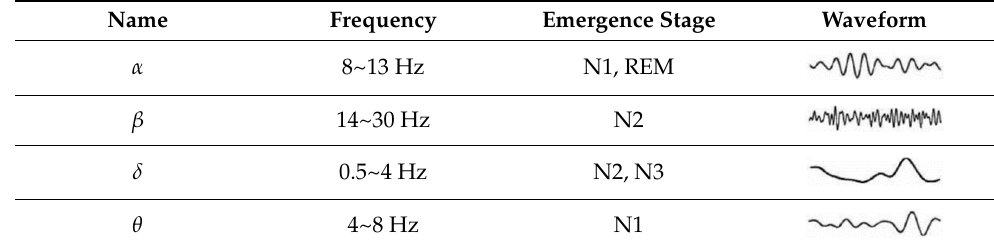
Table 1. Common EEG features and their appearance stages and waveforms.